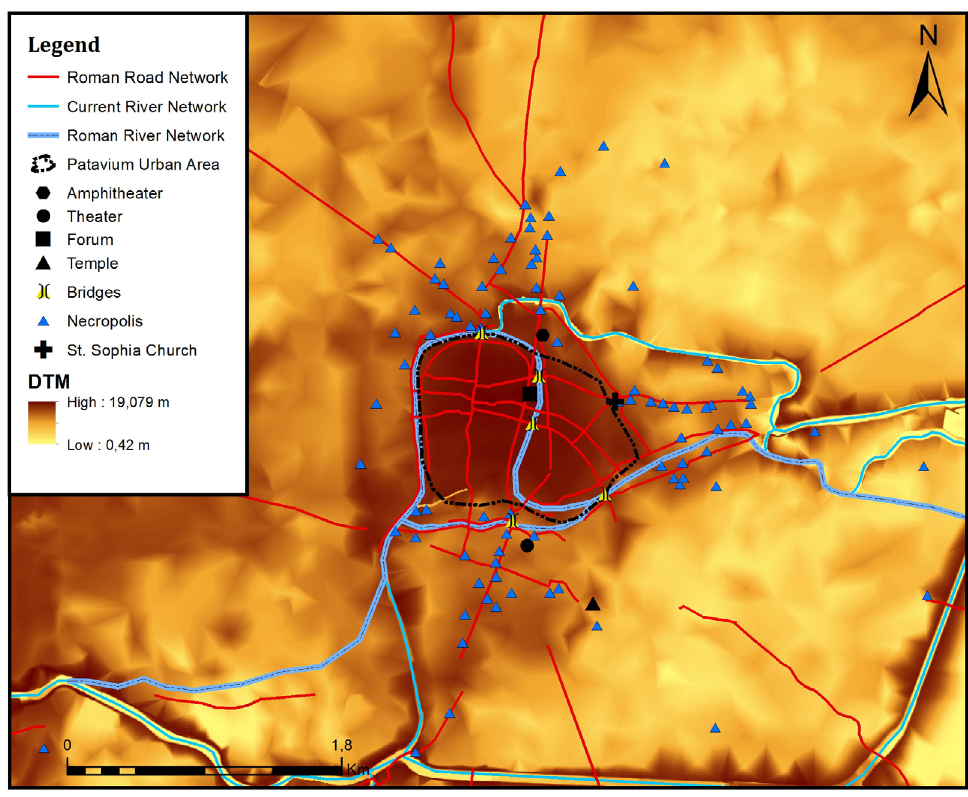
Fig. 7 Patavium and the ancient road network inside and around the